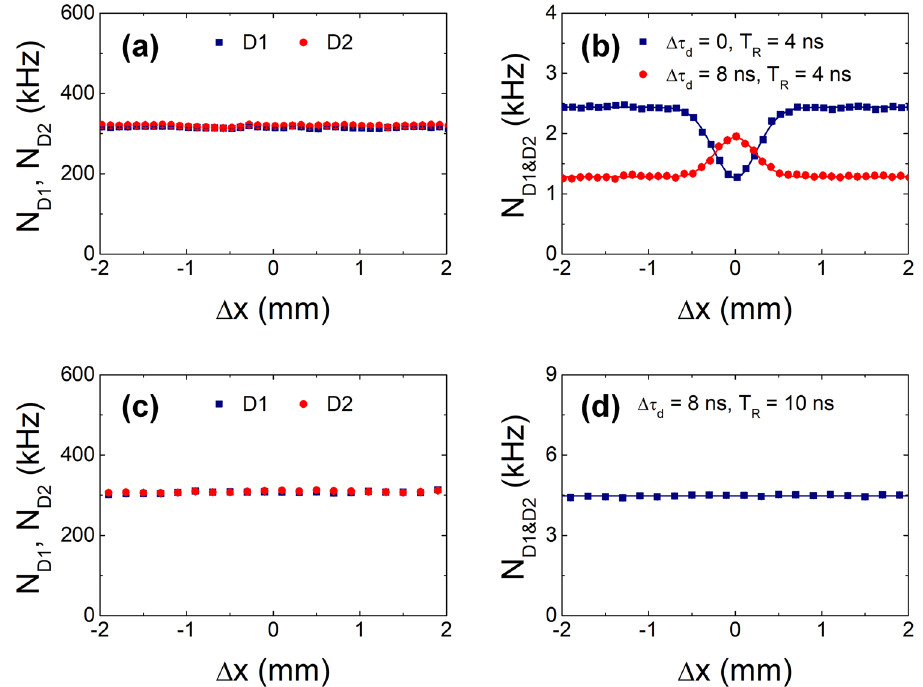
Figure 8. Single ( N D1 , N D2 )- and coincidence ( N D1&D2 )-counting rates as functions of the path-length difference for two temporally separated input photons ( (cid:31) t = 8 ns). ( a , b ) Measurements were performed with ( �τ d = 8 ns) and without ( �τ d = 0) temporal filtering for a coincidence resolving time window of T R = 4 ns. ( c , d ) Measurements were performed with �τ d = 8 ns and T R = 10 ns.